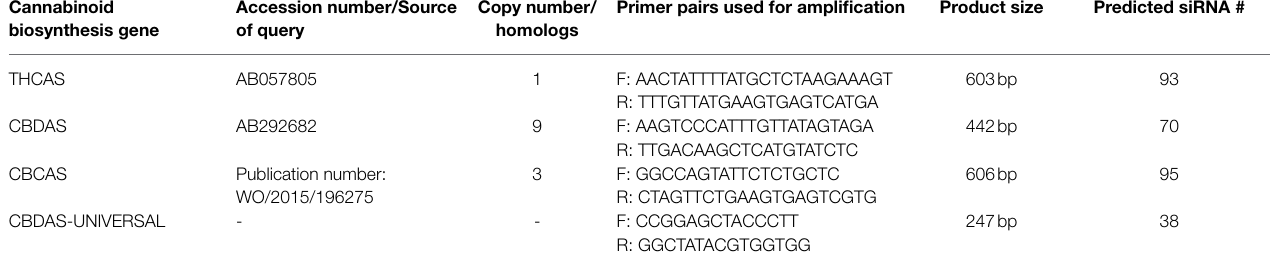
TABLE 1 | Cannbio-2 analysis of cannabinoid biosynthesis genes with PCR amplification, copy number, and siRNA prediction information. Cannabinoid biosynthesis gene